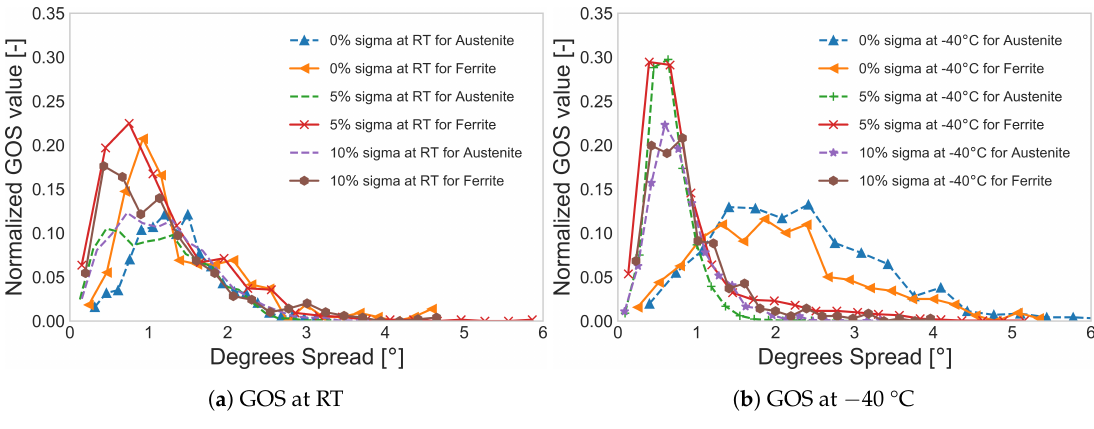
Figure 10. The grain orientation spread curves for the different specimens. ( a ) are the specimens tested at room temperature and ( b ) are the specimens tested at − 40 °C. All curves were taken after 6% strain. The solid lines are ferrite and the dashed lines are